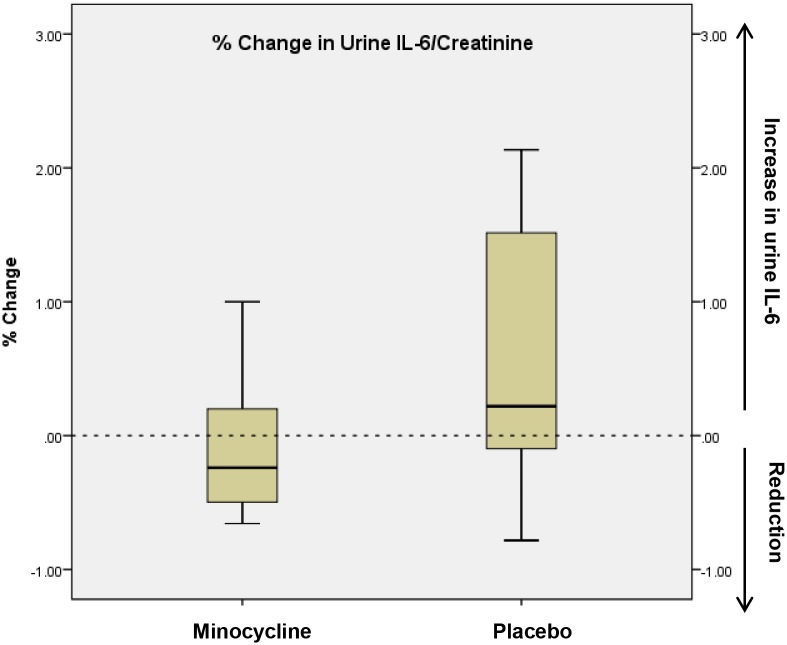
% change in 24-hour urine Il-6: creatinine measurements from baseline to 6 months in placebo and minocycline groups.The edges of the boxes represent the 25% and 75% percentiles, the middle lines represents the median, and the whiskers extend to the minimum and maximum values. The %change in urine IL-6: creatinine was significantly lower in the minocycline group vs. the placebo group (mean % change -0.13 vs. 0.60, P = 0.03).